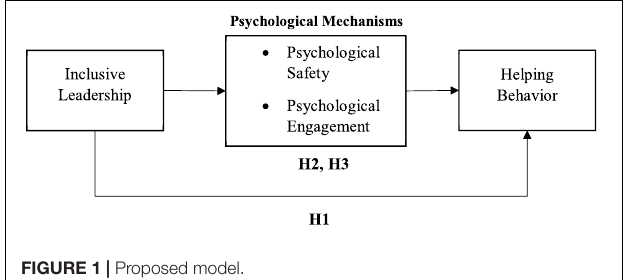
FIGURE 1 | Proposed